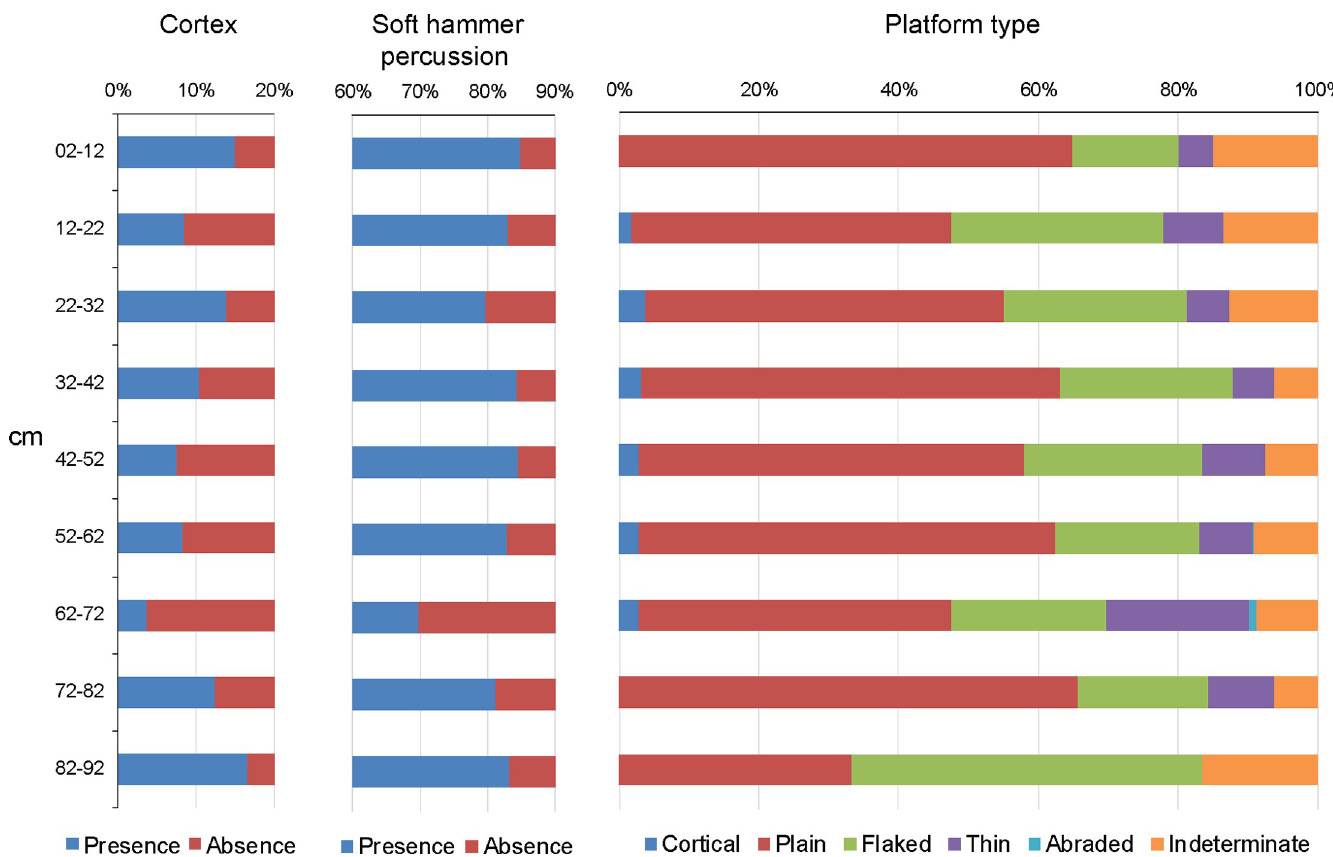
Fig 7. Main technological attributes of the lithic assemblage. Considers only complete and proximal fragments of piece plotted specimens.